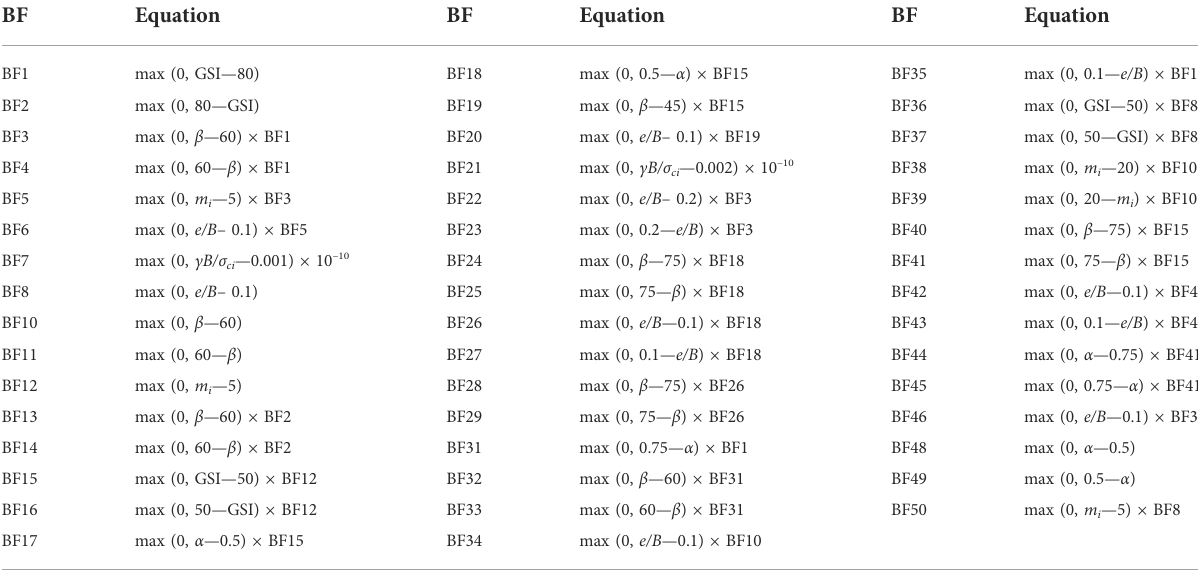
TABLE 3 Basic functions and correlation equation obtained from the MARS analysis.